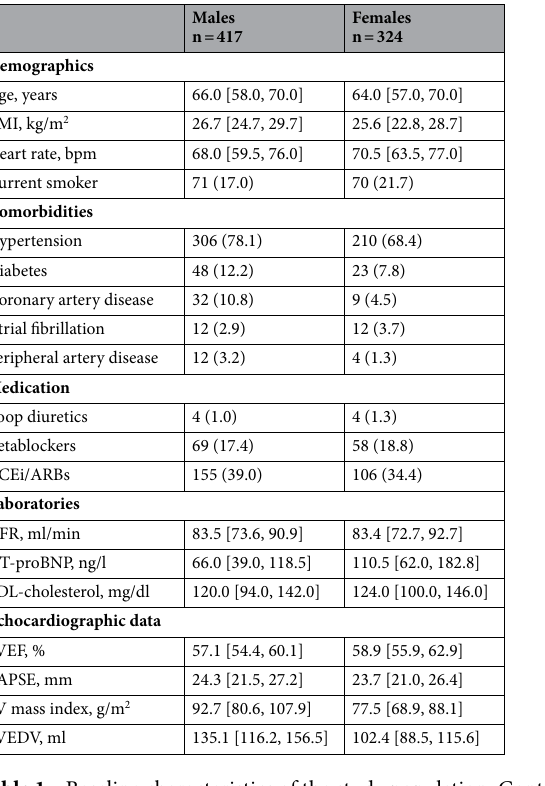
Table 1. Baseline characteristics of the study population. Continuous variables are presented as median and interquartile range, categorical variables are presented as absolute numbers and percentages. ACEi angiotensin- converting enzyme inhibitor, ARB angiotensin receptor blocker, BMI body mass index, GFR glomerular filtration rate, LAVI left atrial volume index, LDL low-density lipoprotein, LV left ventricle, LVEDV left ventricular end-diastolic volume, LVEF left ventricular ejection fraction, NT-proBNP N-terminal pro-B-type natriuretic peptide, TAPSE tricuspid annular peak systolic excursion.